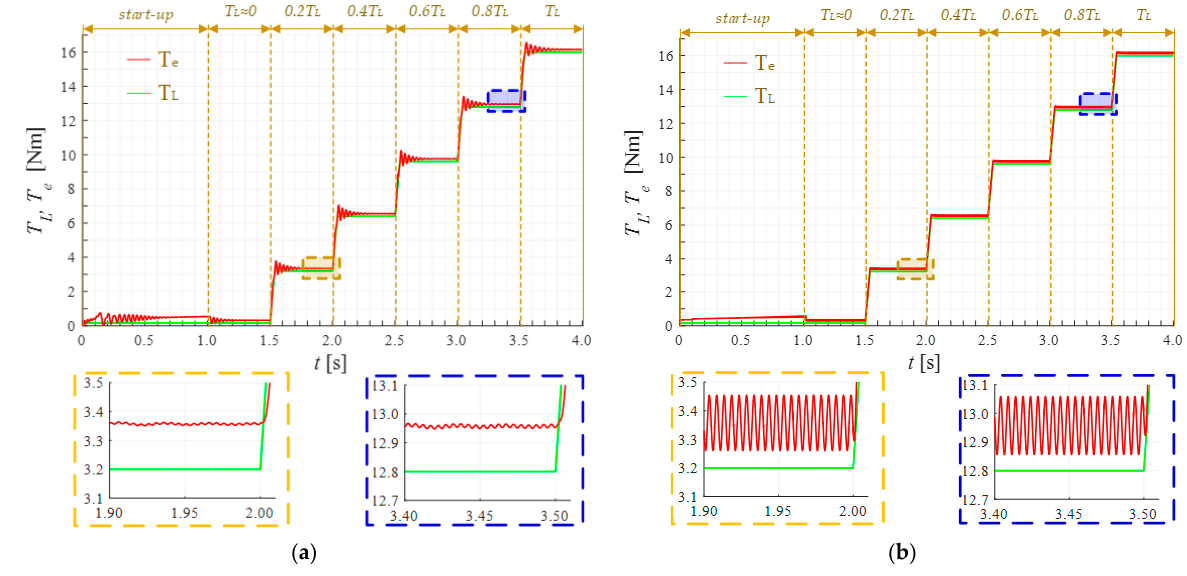
Figure 10. Transients of the electromagnetic torque and load torque for the faulty PMSM, N sf = 8, f s = 100 Hz: scalar control ( a ), field-oriented control ( b ).